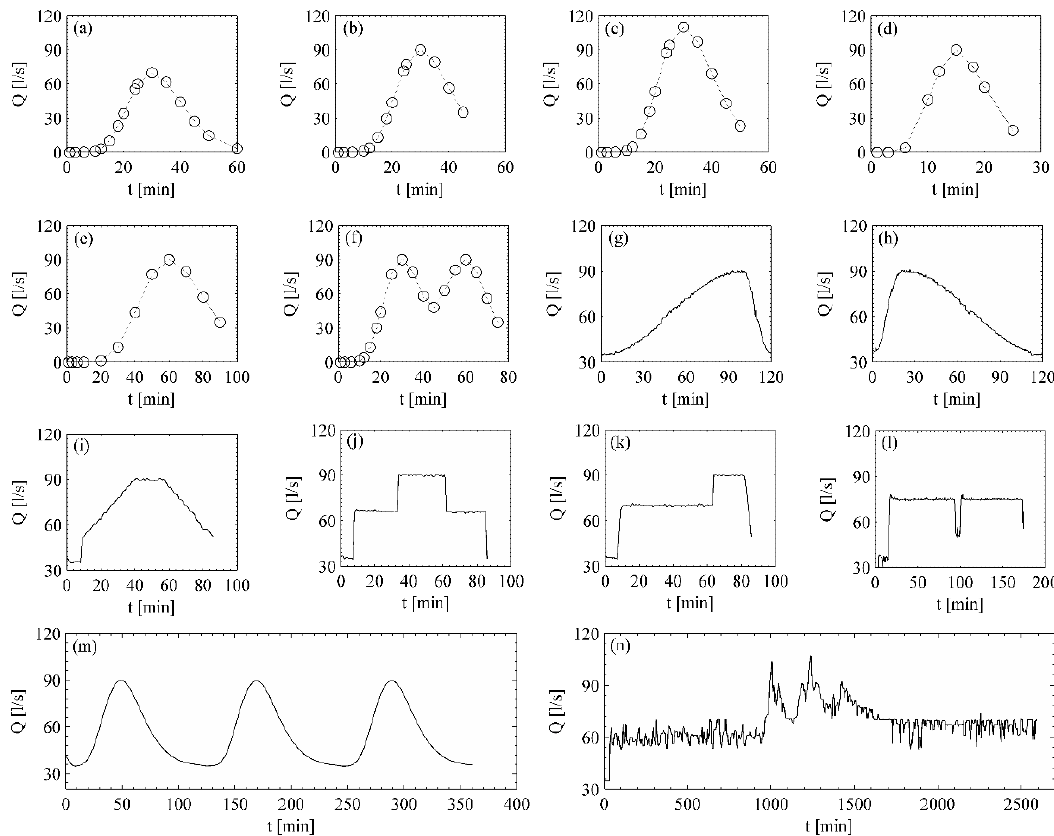
Figure 1. Unsteady runs employed in this study. Images ( a – f ) are experiments 2005OLIVETO01U, 2005OLIVETO02U, 2005OLIVETO03U, 2005OLIVETO04U, 2005OLIVETO05U and 2005OLIVETO06U, respectively; images ( g – l ) are experiments 2017PIZARRO01U, 2017PIZARRO02U, 2017PIZARRO03U, 2017PIZARRO04U, 2017PIZARRO05U and 2017PIZARRO06U, respectively; and images ( m , n ) are experiments 2017LINK01U and 2017LINK02U, respectively.